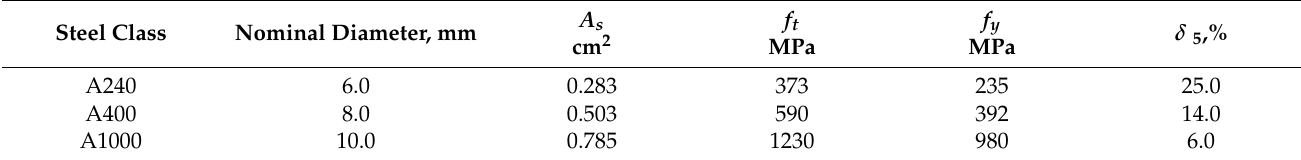
Table 3 uses the following designations: A s —a cross-section of the reinforcement bar, cm 2 ; f t —tensile strength of reinforcement, MPa; f